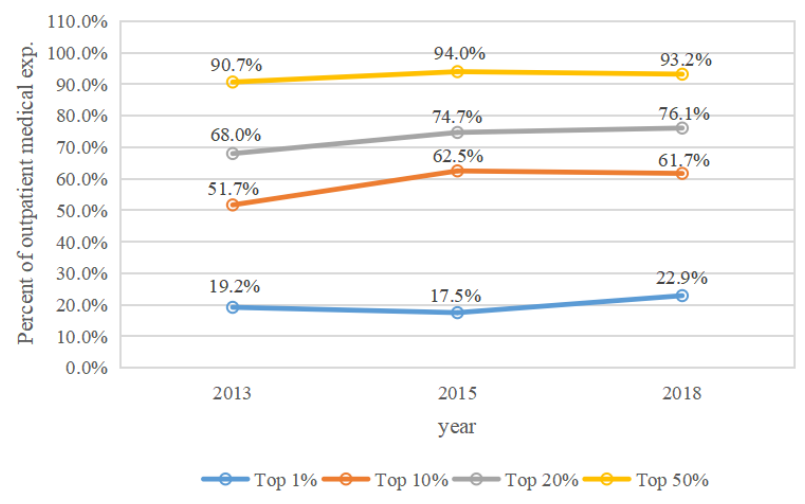
Figure 3. The concentration of outpatient medical expenses by year.